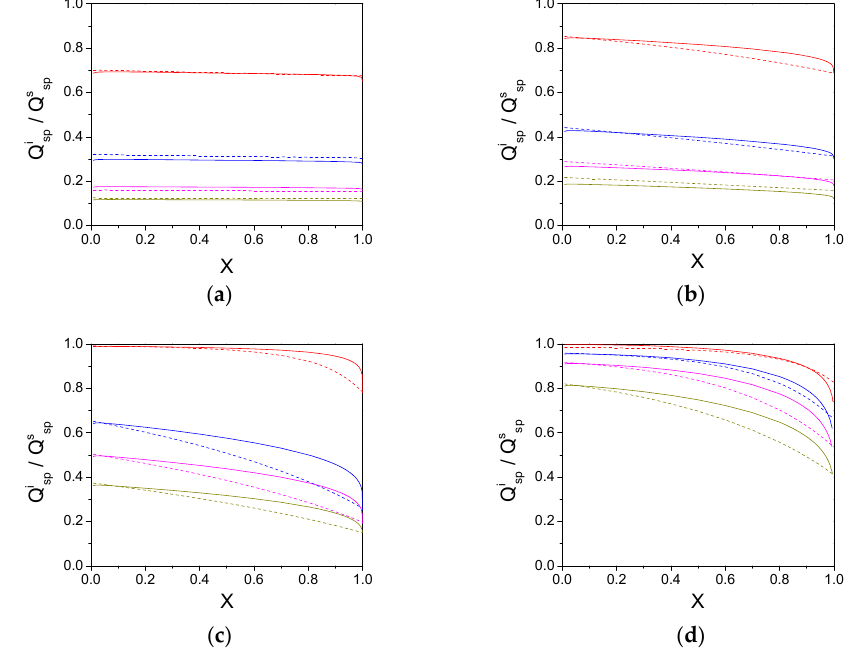
Figure 4. Ratio between immobilized PGA catalyst and soluble PGA-specific productivities (continuous lines) for the hydrolysis of penicillin G with di ff erent initial PenG concentrations (S 0 / K M ) and Thiele moduli ( Φ ): ( a ) S 0 / K M = 0.1; ( b ) S 0 / K M = 1.0; ( c ) S 0 / K M = 10; ( d ) S 0 / K M = 100. Results for the mean integral EF were calculated from the concentration profiles inside catalyst particles (dotted lines). All specific productivities were calculated from data in Figure 2. Legends are the same as those in Figure